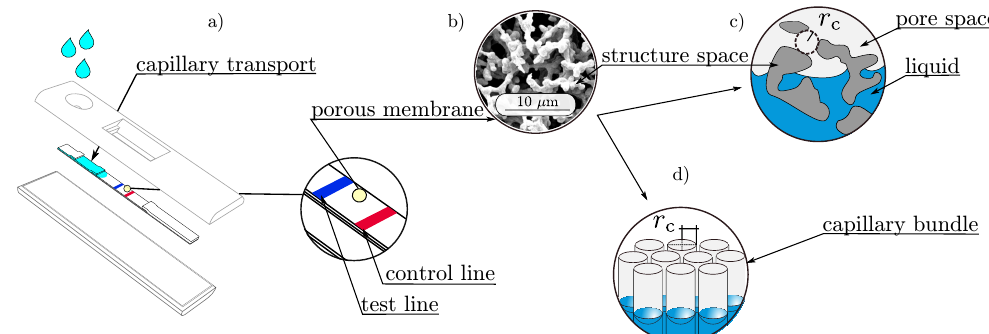
Figure 1. Graphical overview: ( a ) A typical design of a lateral flow assay (LFA), with highlighted test and control lines; ( b ) scanning electron microscopy (SEM) image of a porous polymeric membrane (PPM); ( c ) schematic representation of the pore and the structure spaces [6]; ( d ) Lucas–Washburn assumption of a porous medium, as a bundle of parallel capillaries